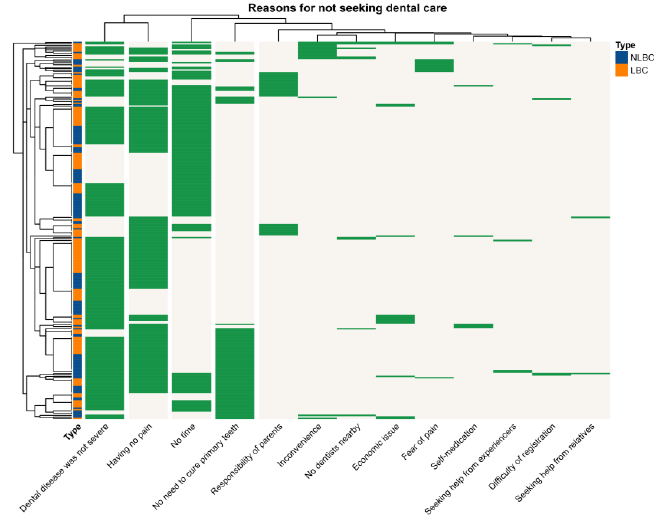
Figure 4. Heatmap showing clustering of reasons for not seeking dental care among participates.